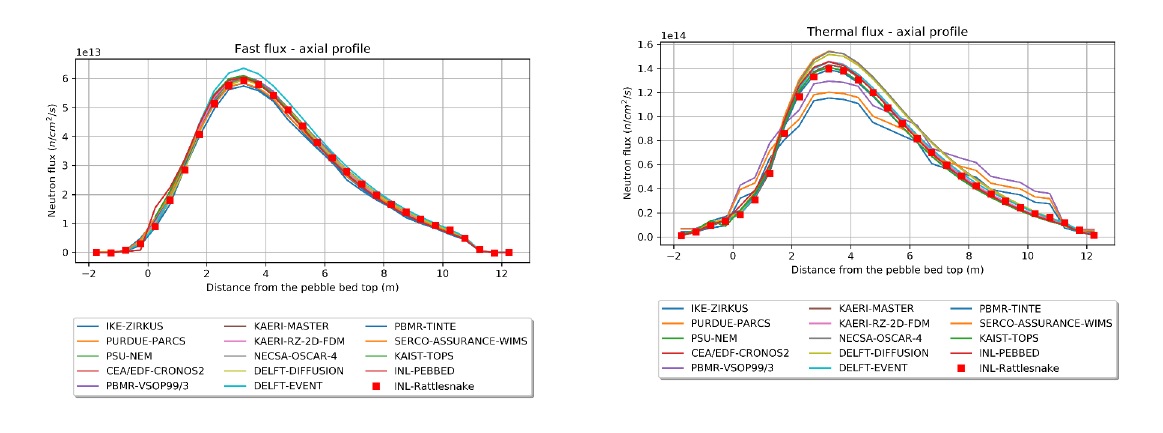
Figure 5: Thermal flux - Axial Profile